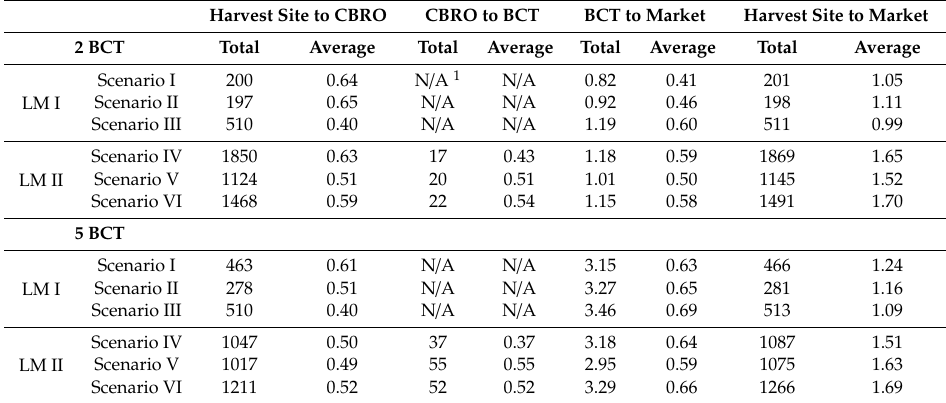
Table 3. Average and total one-way travel times (in hours) for models having two and five BCT moves per work year. CBRO and BCT denotes centralized biomass recovery operation and biomass conversion technology,